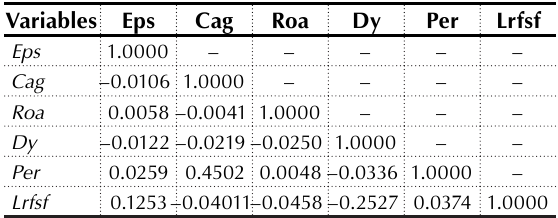
Table 3. Pairwise Correlation Matrix (Growth Stock Portfolio)